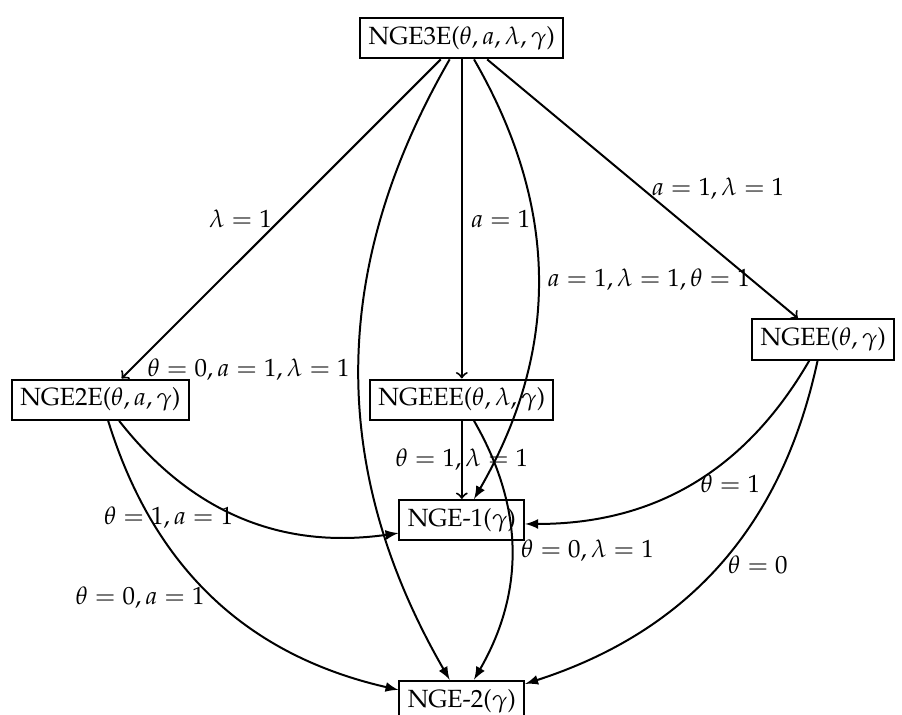
Figure 1. Relationship among submodels of the NGE3ED.